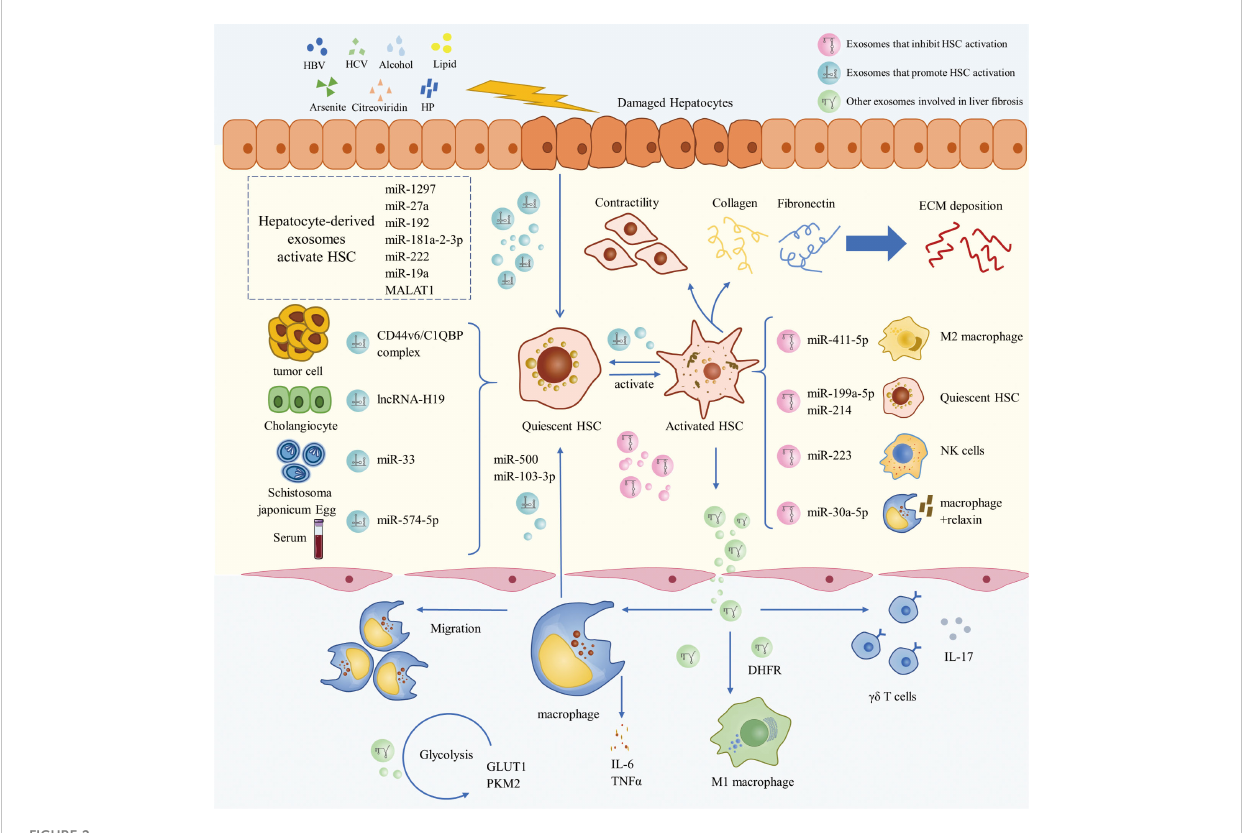
FIGURE 2 The role of exosomes in the pathogenesis of